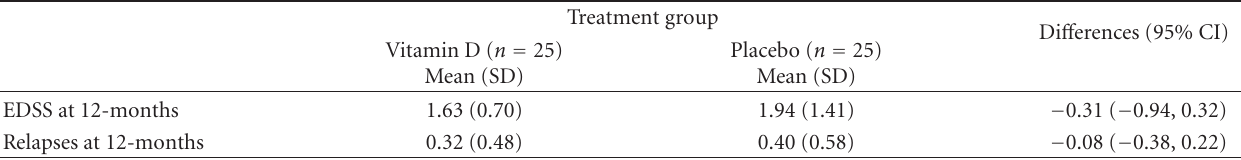
Table 3: Comparison of Expanded Disability Status Scale (EDSS) and relapses in 50 patients with relapsing-remitting multiple sclerosis after 12 months of treatment with low-dose vitamin D and placebo.